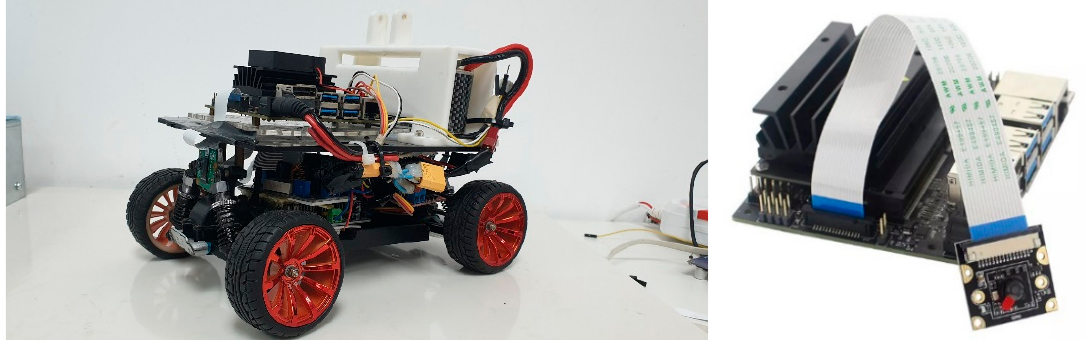
Figure 24. Jetson nano-powered mobile robot with 8-megapixel Raspberry Pi camera